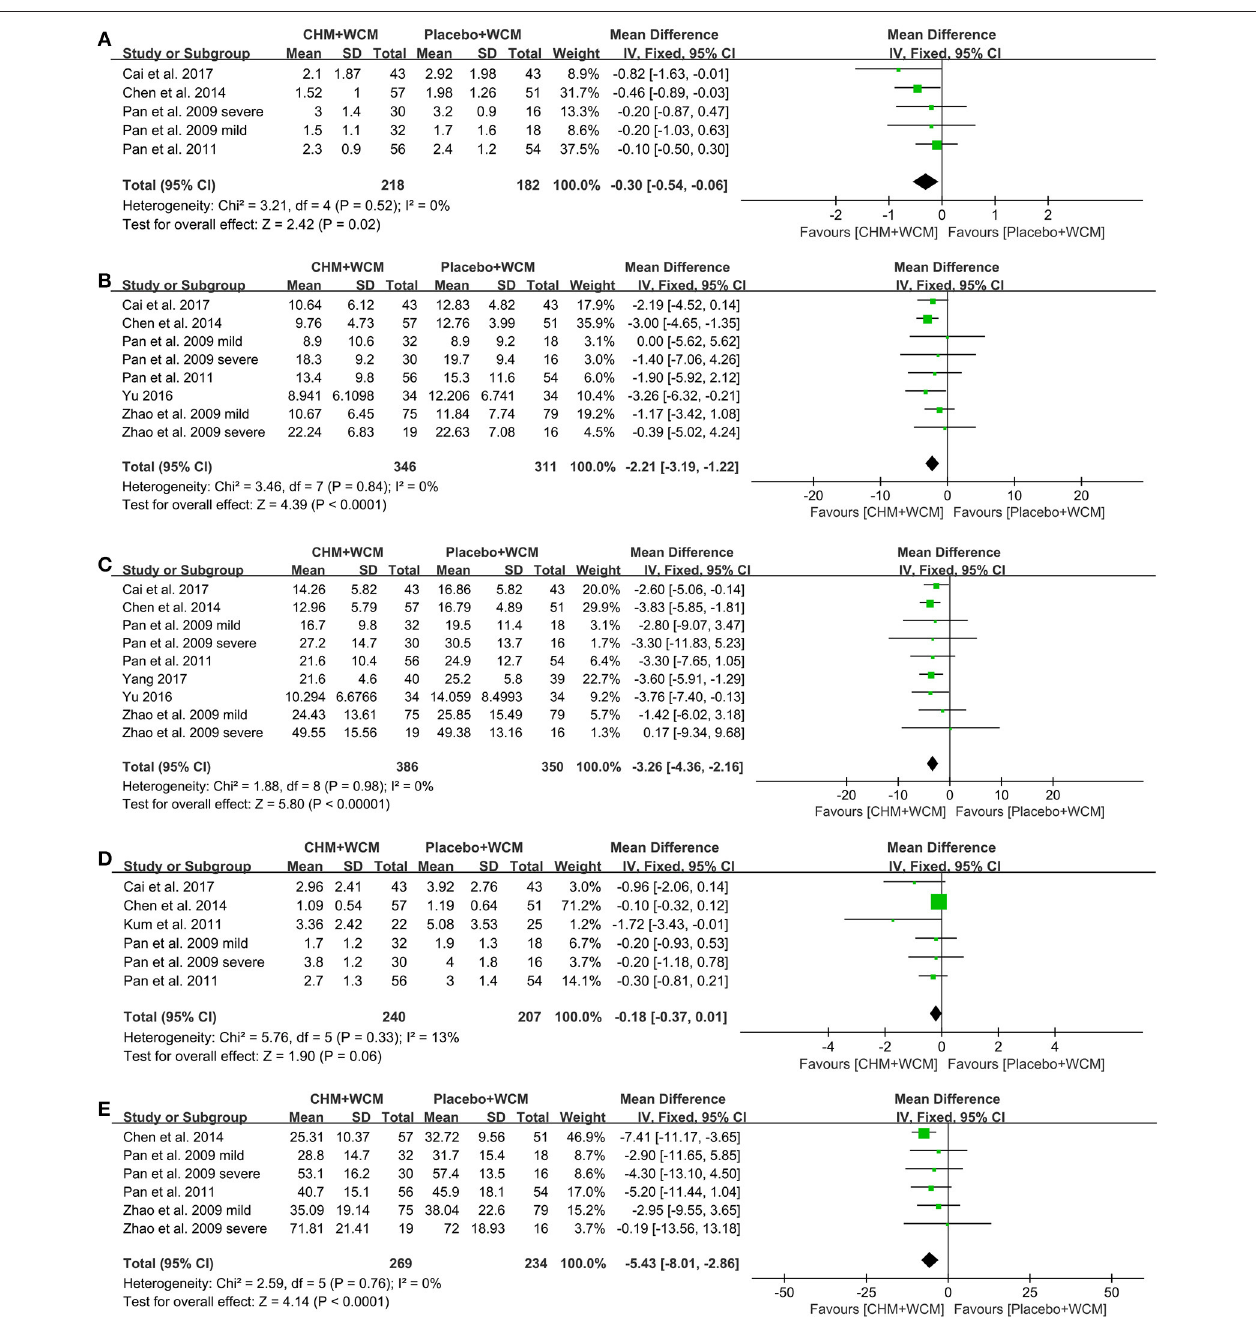
FIGURE 3 | Forest plot of HM plus WCM vs. placebo plus WCM in terms of (A) UPDRS I, (B) UPDRS II, (C) UPDRS III, (D) UPDRS IV, and (E) Total UPDRS Score. (HM, herbal medicine; WCM, western conventional medicine; UPDRS, Unified Parkinson’s Disease Rating